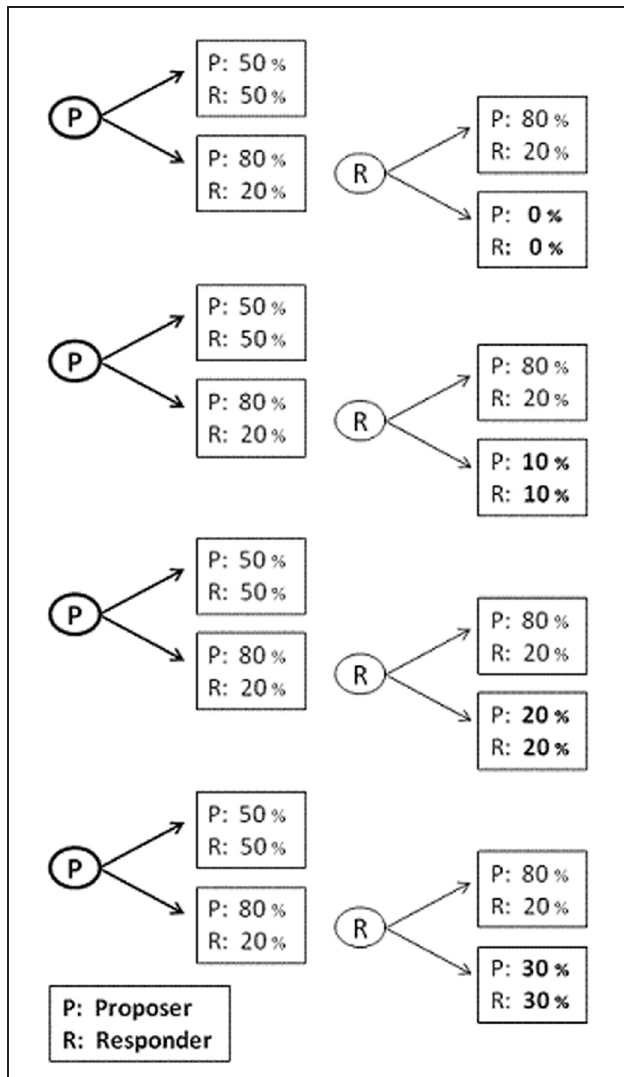
FIGURE 1 | Experiment 1’s UG task with four different